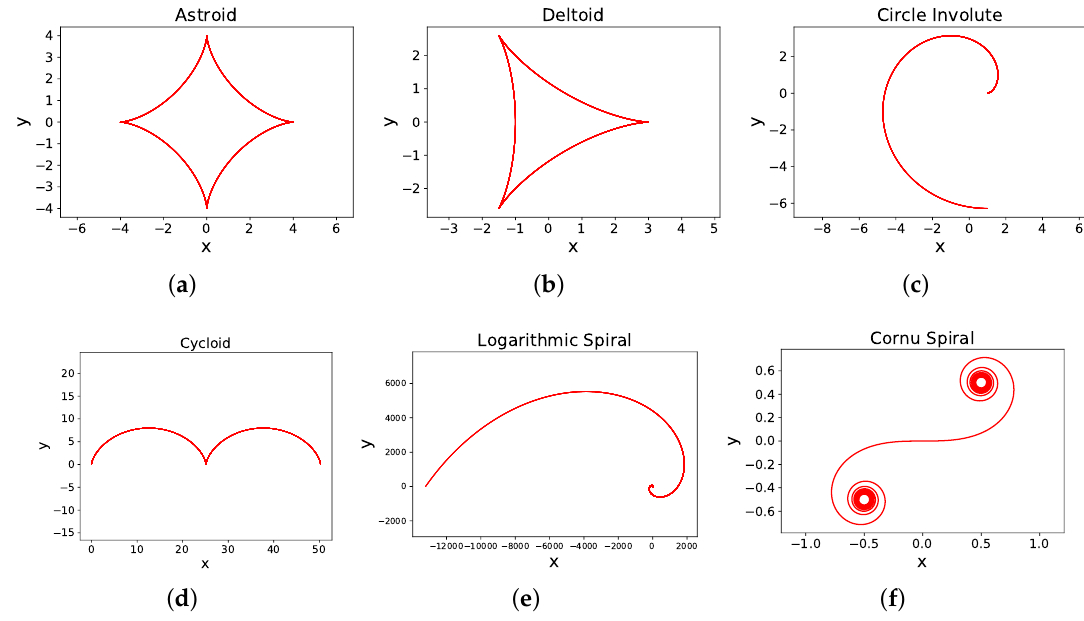
Figure 7. Curves for path smoothing. ( a ) Astroid. ( b ) Deltoid. ( c ) Circle Involute. ( d ) Cycloid. ( e ) Logarithmic Spiral. ( f ) Clothoid or Cornu Spiral (Euler’s Spiral).